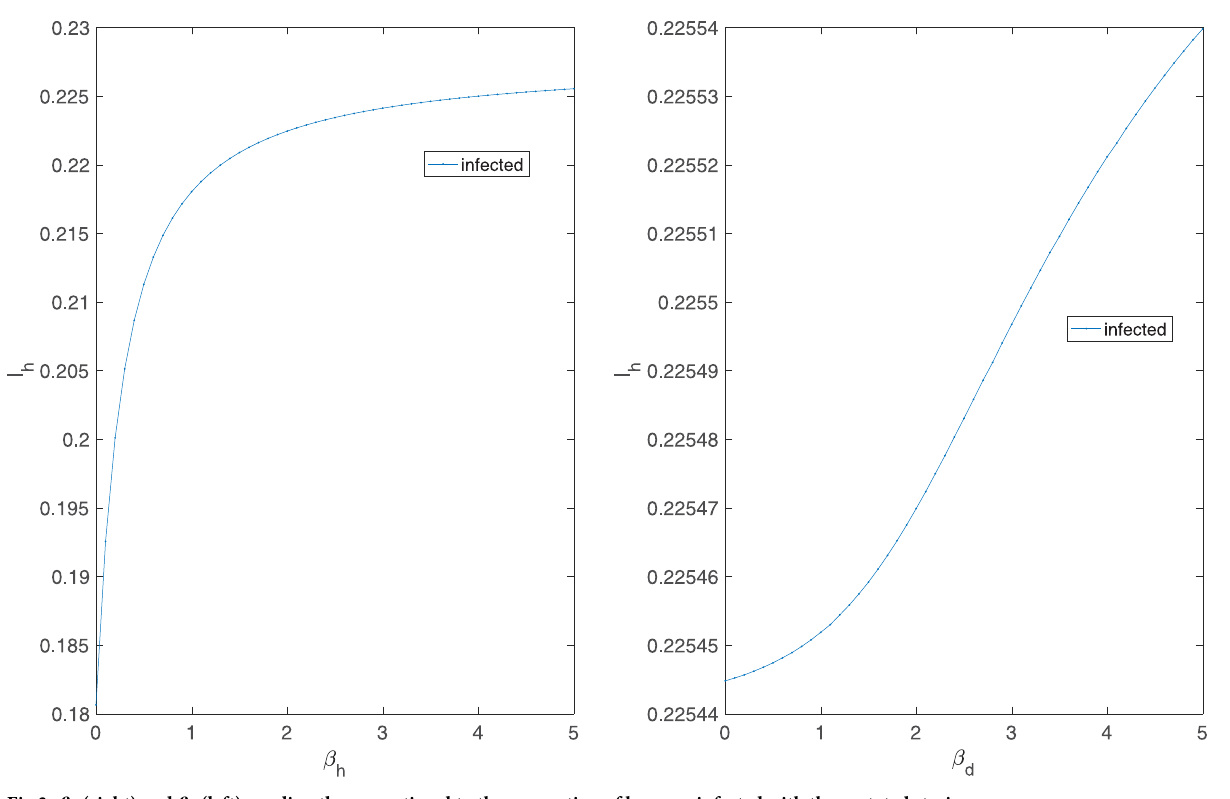
Fig 3. β h (right) and β d (left) are directly proportional to the proportion of humans infected with the mutated strain.